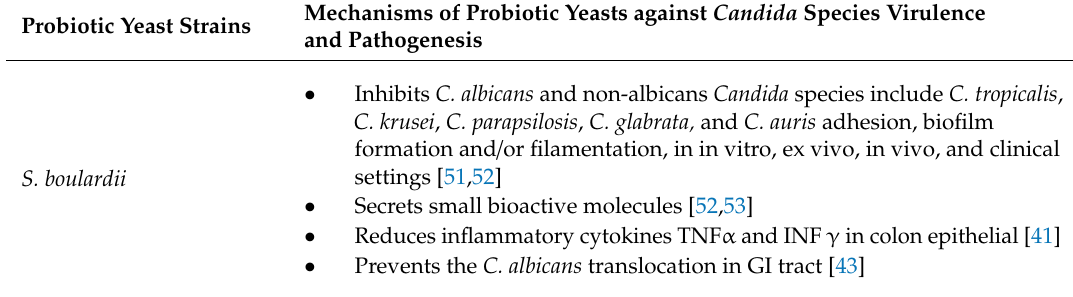
List of probiotic yeasts and its mechanisms against virulence and pathogenesis of Candida